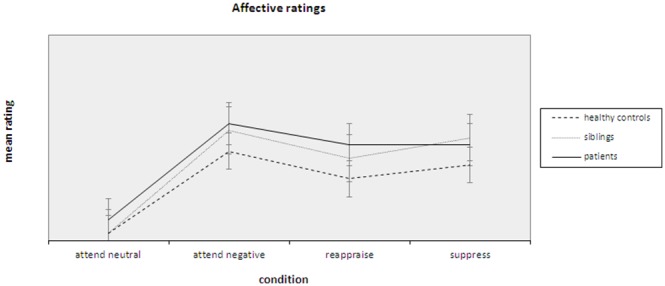
Affective ratings for the emotion regulation task per condition.Lines represent the three groups separately.